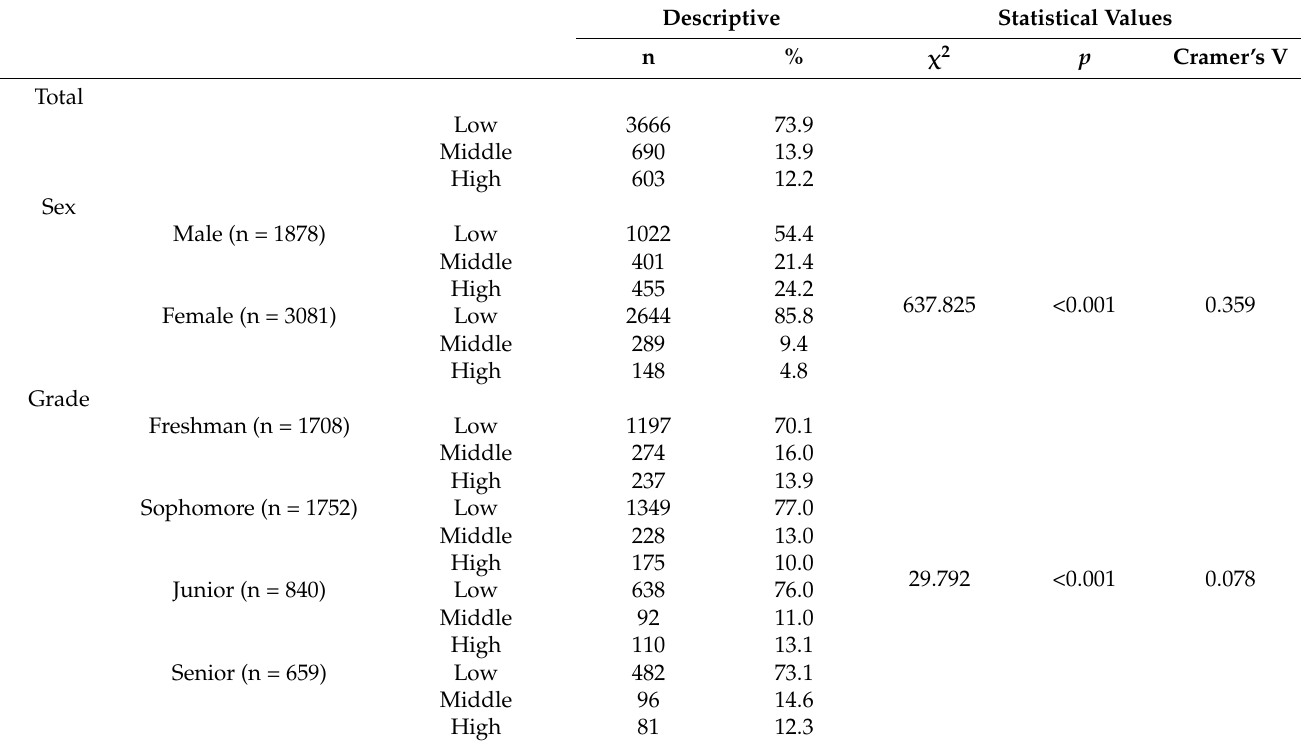
Table 2. Status of physical exercise among university